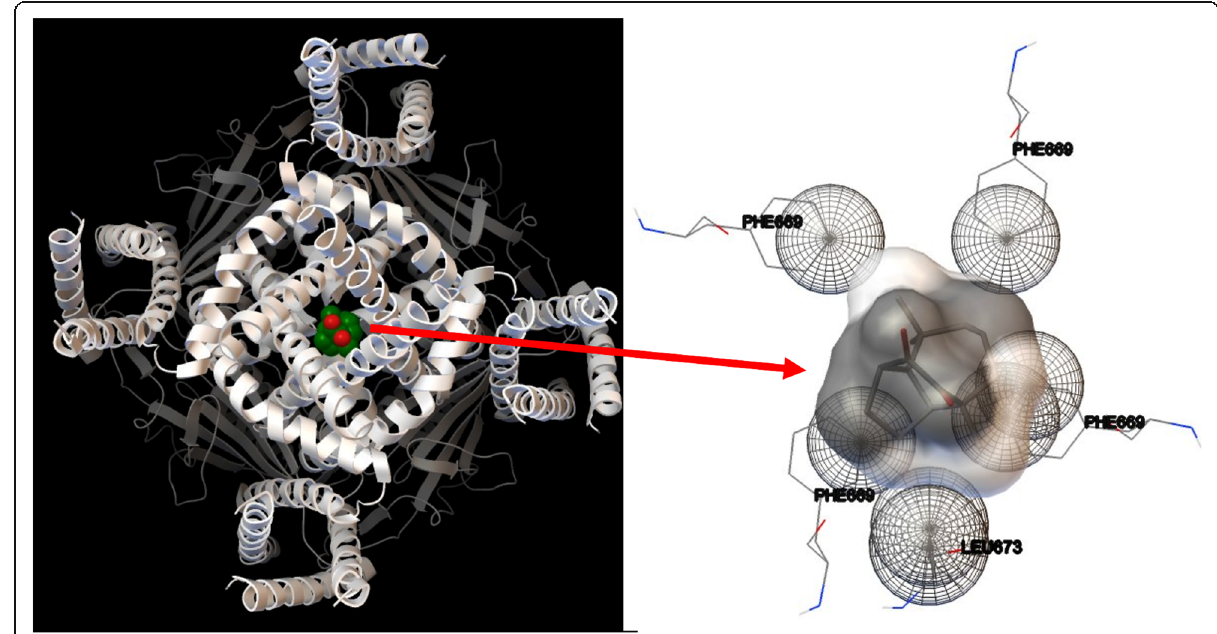
Fig. 4 In-silico docking representation of 1,2-Longidione with Polycystic Kidney Disease protein 2